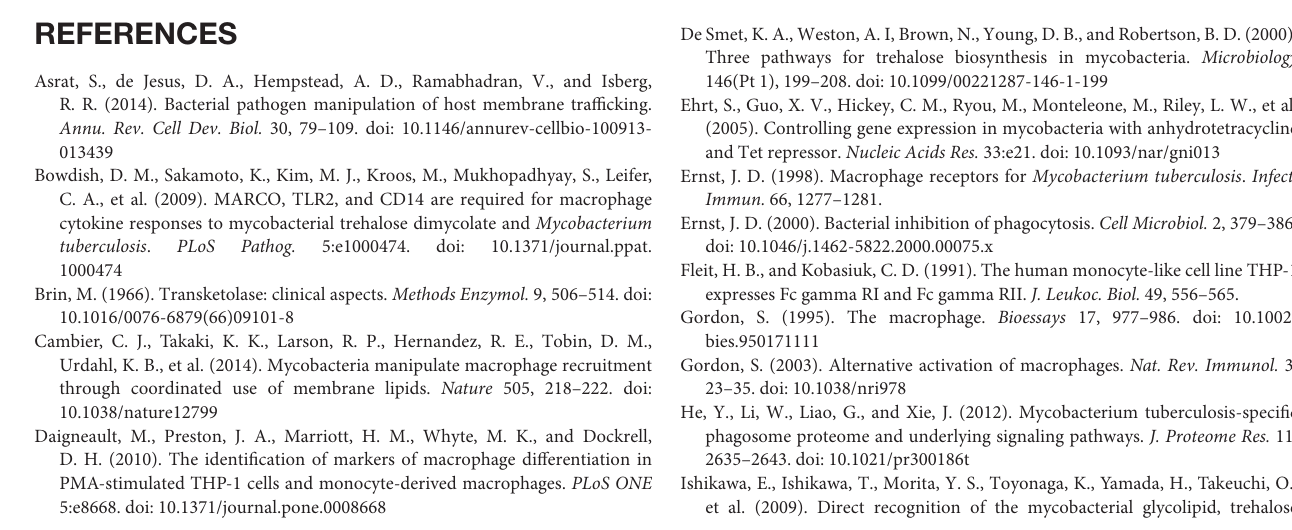
FIGURE S1 | OtsB2 over-expression increases bacteria growth in the stationary phase. (A) Western Blot of WT BCG and BCG-OtsB2 following induction with 50 ng/ml ATc probed by primary antibody against hexahistidine tag, which is N-terminally expressed in the recombinant OtsB2 protein. Lanes (1) WT BCG log phase, (2) WT BCG early stationary phase, (3) WT BCG mid-stationary phase, (4) BCG-OtsB2 log phase, (5) BCG-OtsB2 early stationary phase, (6) BCG-OtsB2 mid-stationary phase (B) BCG over-expressing OtsB2 (pTet-OtsB2) grew to denser culture during stationary phase. (C) Late stationary phase was associated with increased cellular content of trehalose in pTet-OtsB2 cells. Results representative of at least two different experiments. ∗ p < 0.05, ∗∗∗ p < 0.001 by Student’s t -test. FIGURE S2 | BCG-OtsB2 infection causes upregulation of CD1d surface expression. Analysis of surface marker staining of WT BCG and BCG-OtsB2 infected THP-1 macrophages was analyzed by flow cytometry. ∗ p < 0.05, ∗∗ p < 0.01, ∗∗∗ p < 0.001 by Student’s t -test. Results representative of two experiments. FIGURE S3 | BCG-OtsB2 infection does not change expression of mycobacterial phagocytosis receptors on THP-1 macrophages compared with WT BCG. Analysis of surface marker staining of WT BCG and BCG-OtsB2 infected THP-1 macrophages was analyzed by flow cytometry. ∗ p < 0.05 by Student’s t -test. Results representative of two experiments. FIGURE S4 | THP-1 macrophages infected by OtsB2 do not have a general phagocytosis defect. (A) Flow cytometry of macrophages alone (no beads). (B) Flow data of macrophages fed fluorescent beads only. Flow data of macrophages fed fluorescent beads following infection by WT BCG (C) and BCG-OtsB2 (D) . Results representative of three separate experiments. FIGURE S5 | BCG-OtsB2 has greater binding but decreased phagocytosis by RAW264.7 macrophages than WT BCG. Phagocytosis analysis by flow cytometry of WT BCG and BCG-OtsB2 by RAW264.7 macrophages following 24 h incubation at 37 ◦ C [representative flow cytometry data in (A) and quantification of biological triplicates in (B) ]. Binding analysis of BCG-OtsB2 and BCG to RAW264.7 macrophages at 4 ◦ C for 4 h [representative flow cytometry data in (C) and quantitation of biological triplicates in (D) ]. ∗ p < 0.05, ∗∗∗ p < 0.001 by Student’s t -test. Results representative of at least two separate